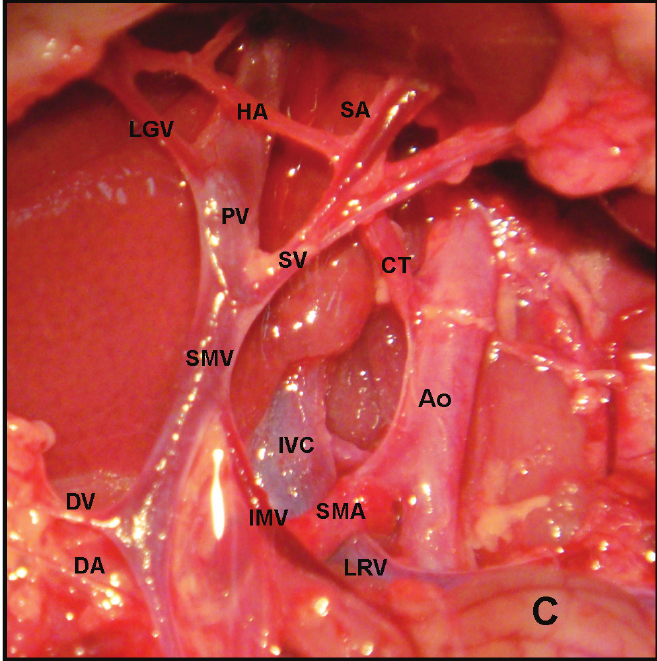
FIGURE 1 - Rat vascular anatomy from the upper abdomen. Ao , abdominal aorta; C , colon; CT , celiac trunk; DA ; duodenal artery; DV , duodenal vein; HA , hepatic artery; IMV , inferior mesenteric vein; IVC , inferior vena cava; LGV ; left gastric vein; LRV , left renal vein; PV , portal vein; SA , splenic artery; SMA , superior mesenteric artery; SMV , superior mesenteric vein; SV , splenic